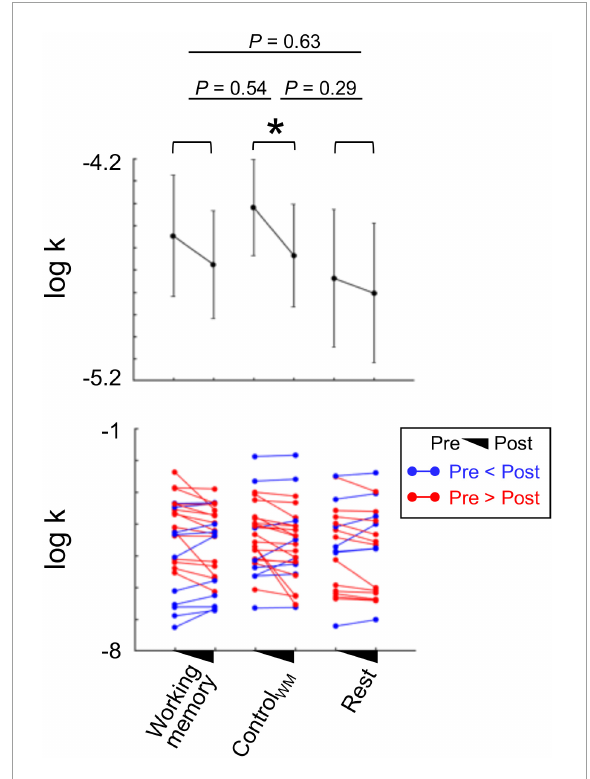
FIGURE4 Impacts of the intervention tasks on reducing